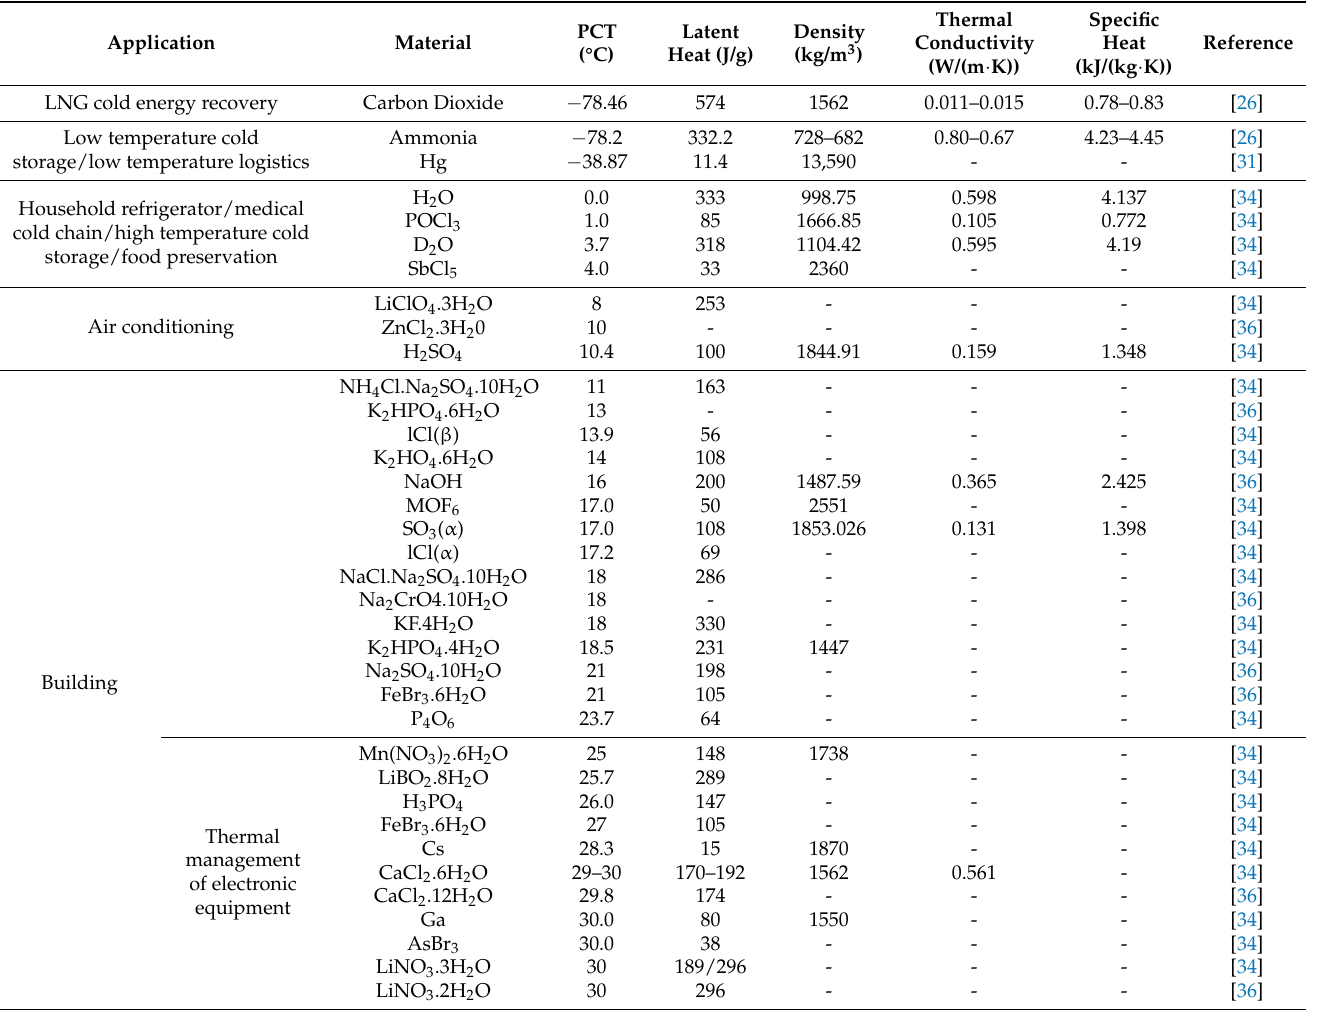
Table 2. Typical inorganic PCMs for cold energy